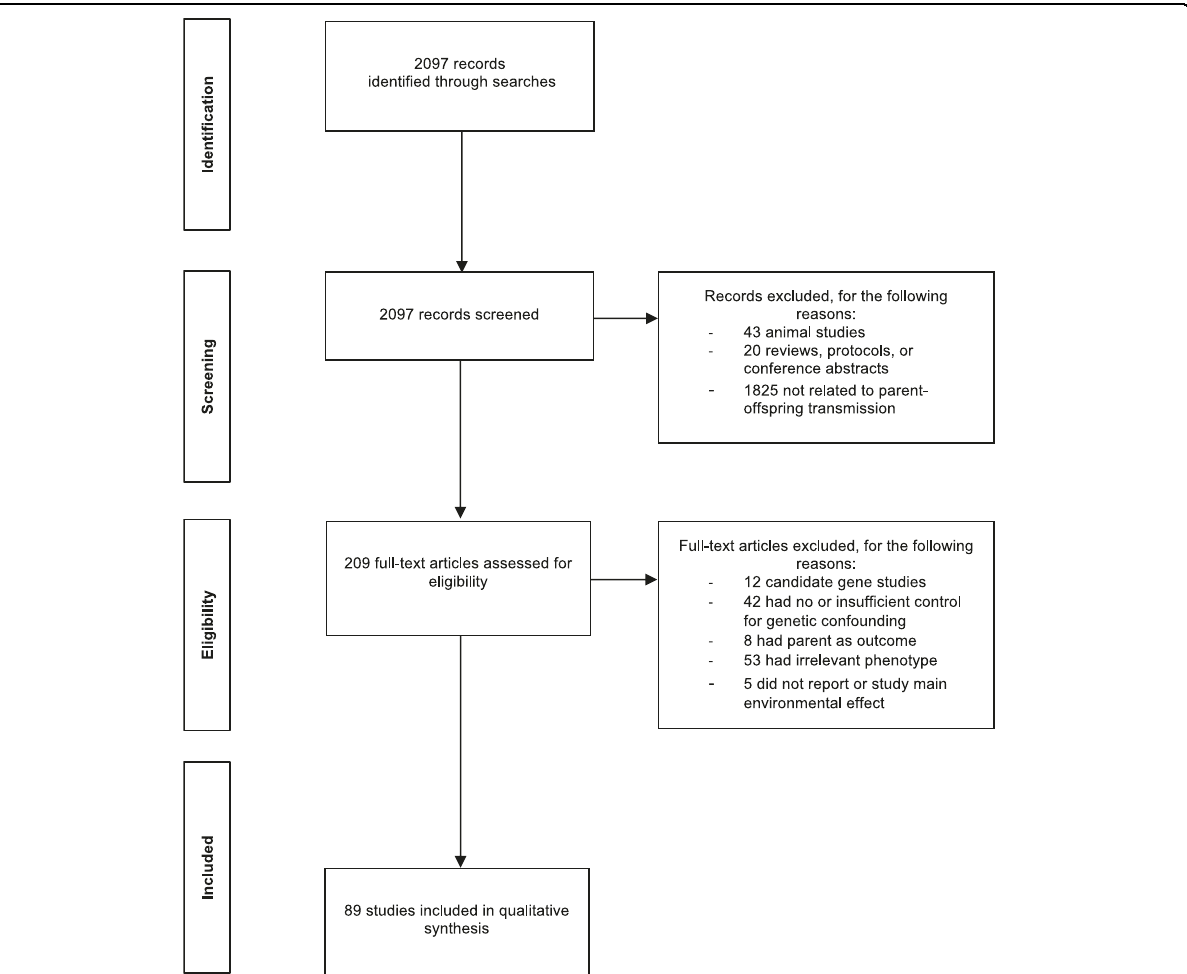
Fig. 3 Flow chart of study selection. A description of the screening and assessment procedure, reporting the number of records excluded and reasons for exclusion at each